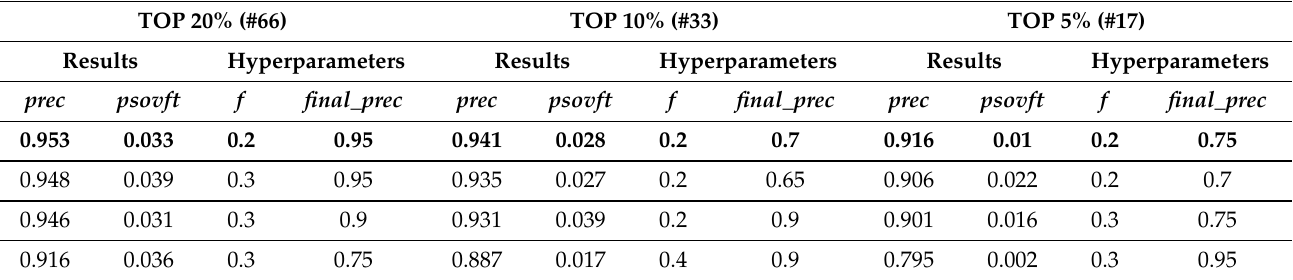
Table 5. Results of different sized feature subsets generated with the proposed FS